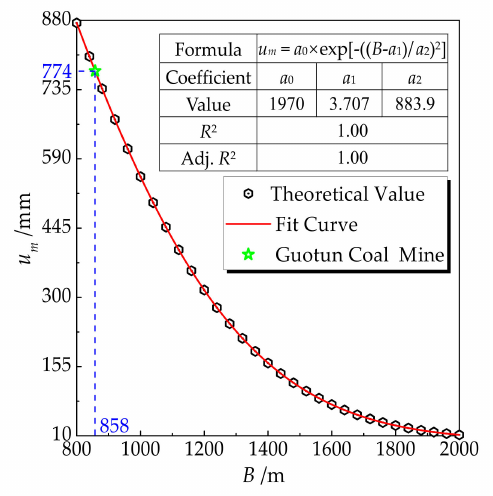
Figure 14. Values of u m under di ff erent values of